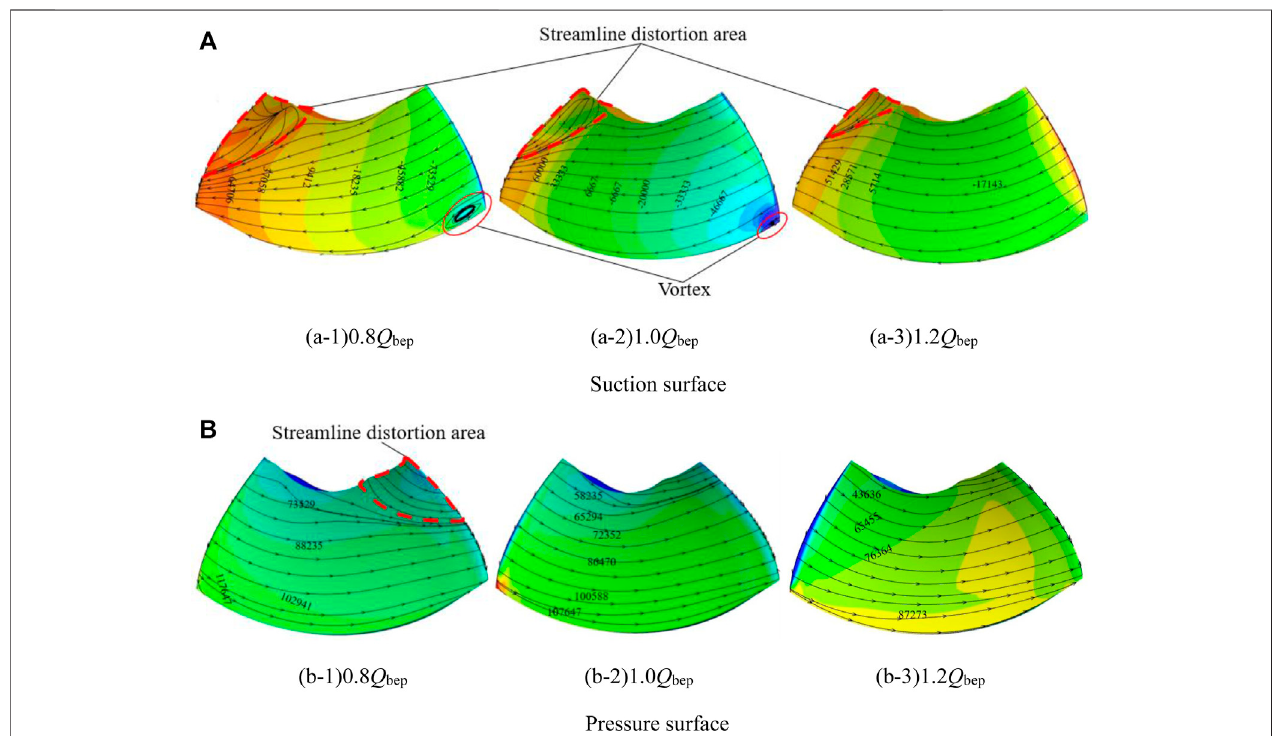
FIGURE 6 | Pressure distribution and streamline distribution of blade surface (Unit: Pa).